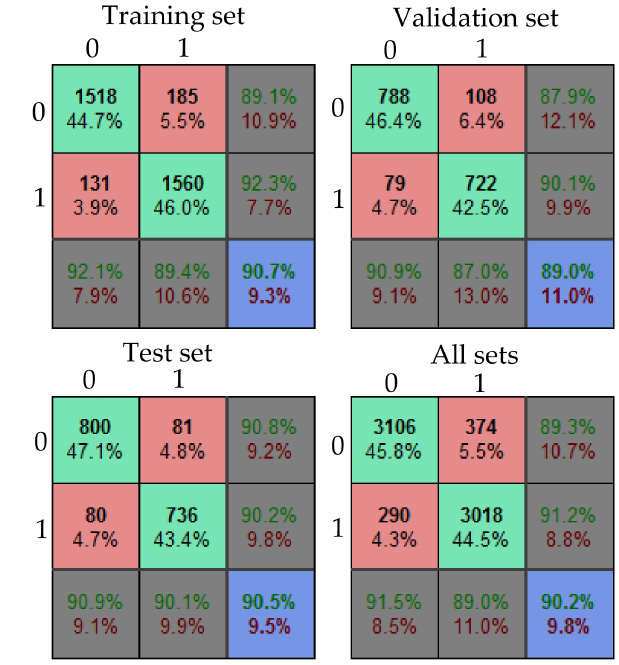
Figure 11. Training results using the BP neural-network model with 450 neurons in the hidden